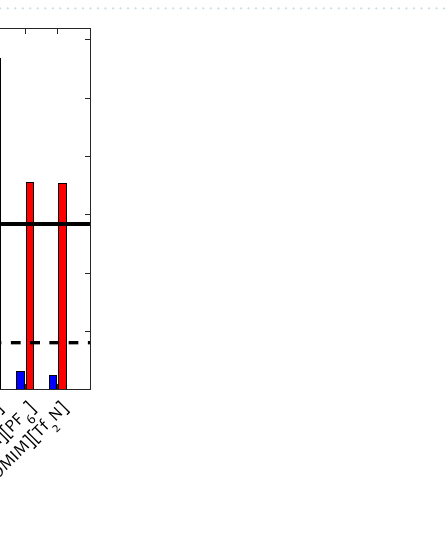
Figure 7. Comparison between LS-SVM and UNIFAC uncertainties 79 to estimate the H 2 S solubility in various